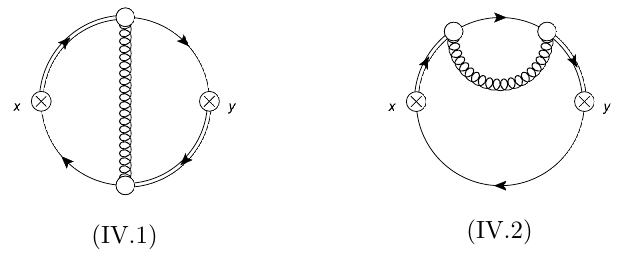
Figure 7. Type IV diagrams for the evolved 2-point vector correlator at O ( g 2